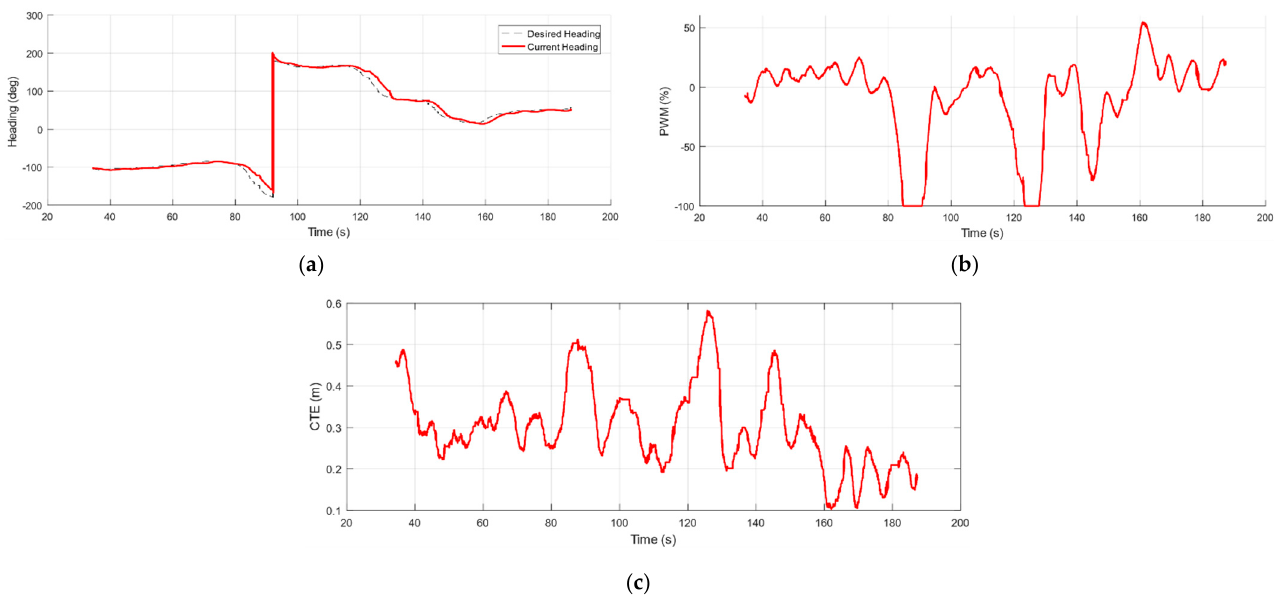
Figure 16. Results of heading error ( a ), PWM signal ( b ) and CTE ( c ) throughout the mission.